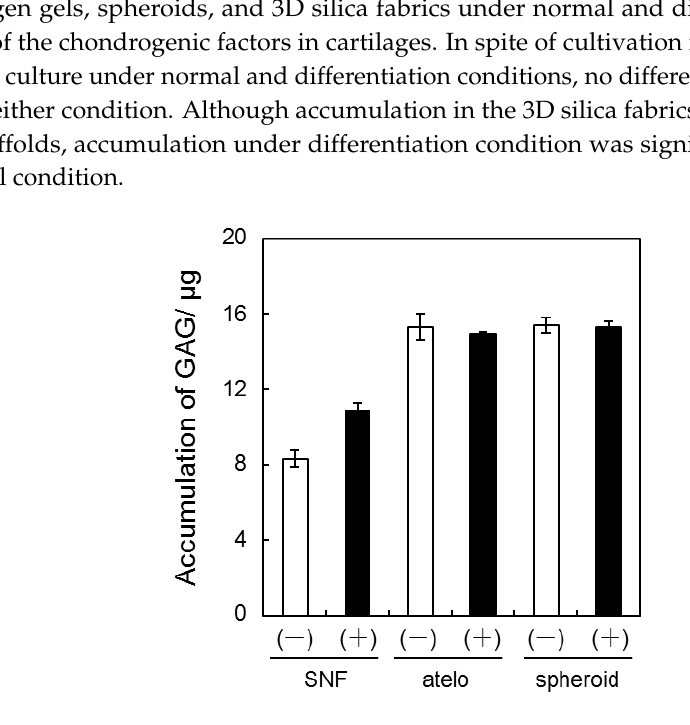
Figure 3. Accumulation of glycosaminoglycan (GAG) in normal medium (Diff ( − )) and chondrogenic differentiation medium (Diff (+)) on 3D silica fibers, atelocollagen gels, and spheroids for 4